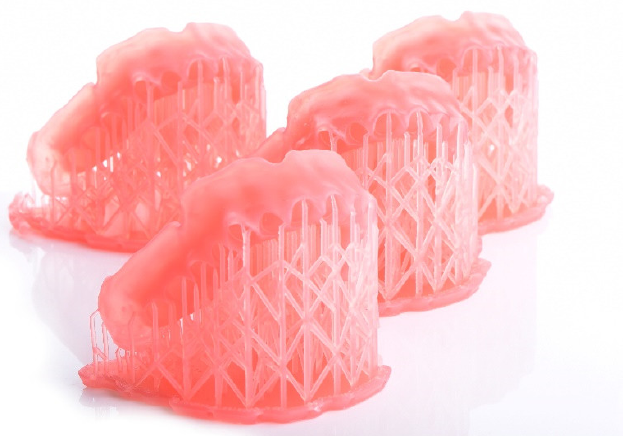
Figure 2. Exemplary 3D printed denture bases (here: stereolithography (SLA) with 45° build an- gle).